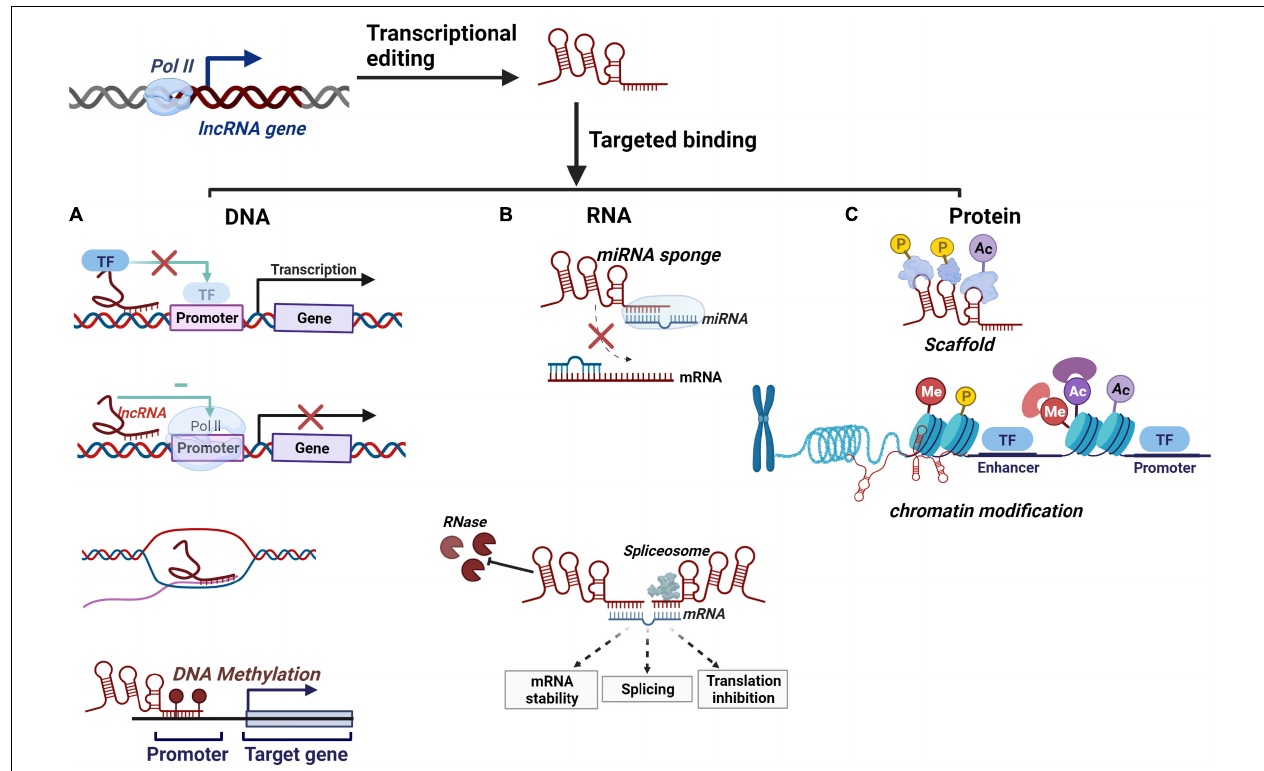
FIGURE 1 | Schematic overview of lncRNAs’ molecular mechanisms. (A) lncRNAs regulate downstream gene transcription by binding to transcription factors, repression of RNA Pol II, complementary pairing with unstranded DNA bases, and DNA methylation. (B) lncRNAs serve as miRNA sponges to competitively bind with miRNA. lncRNAs regulate mRNA transcription by modulating mRNA stability and pre-mRNA splicing. lncRNAs can inhibit RNase degradation and promote mRNA stability. (C) lncRNAs can serve as a scaffold for protein phosphorylation and ubiquitination and regulate chromatin modification by employing histone-modifying